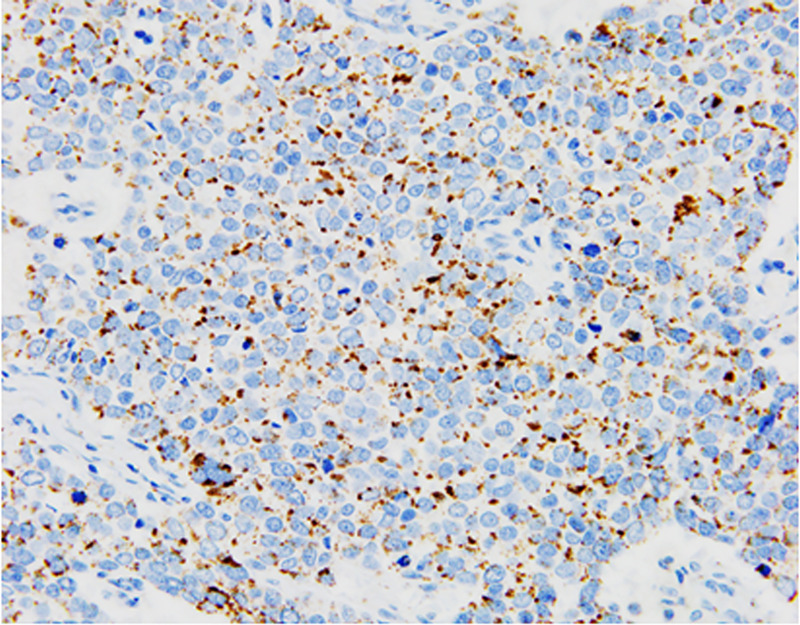
Representative images of the immunohistochemical staining for adipophilin in triple-negative breast cancer (×200 magnification).